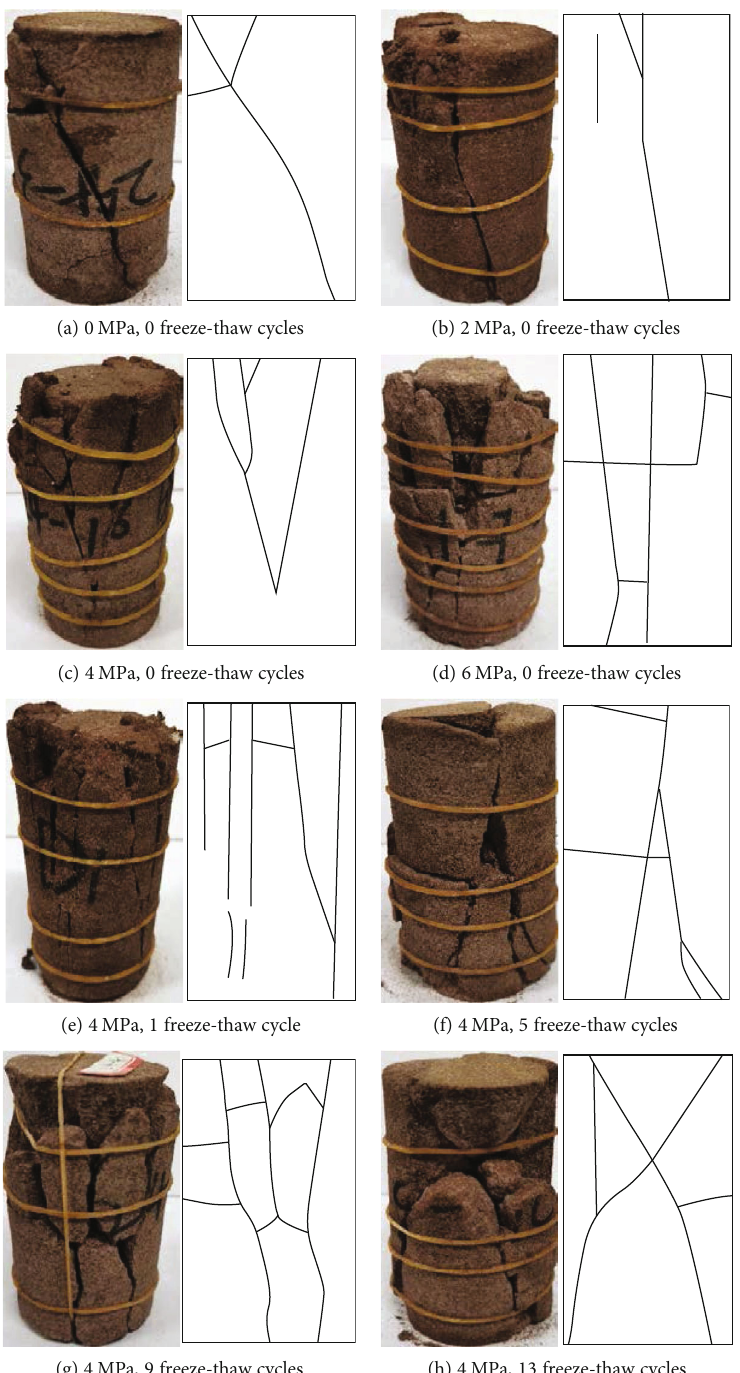
Figure 22: Creep failure modes of the tested red sandstone under di ff erent numbers of freeze-thaw cycles and con fi ning pressures and corresponding